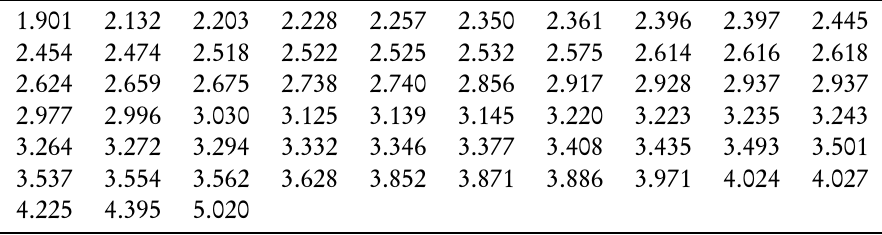
Data set 1 (X: gauge length 10